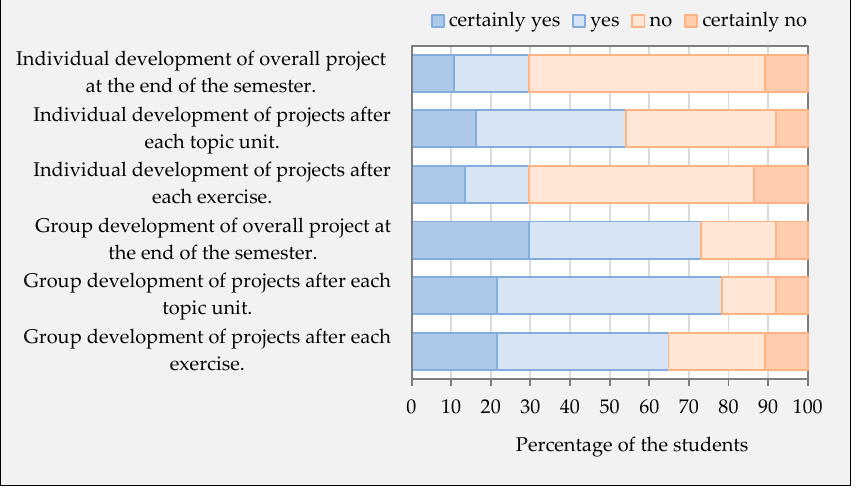
Figure 17. Students’ suggestions for semester project redesign.